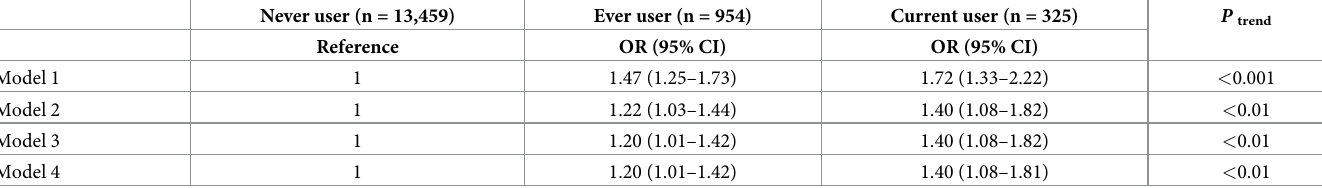
Table 4. Unweighted analysis of the association between metabolic syndrome and electronic cigarette exposure.